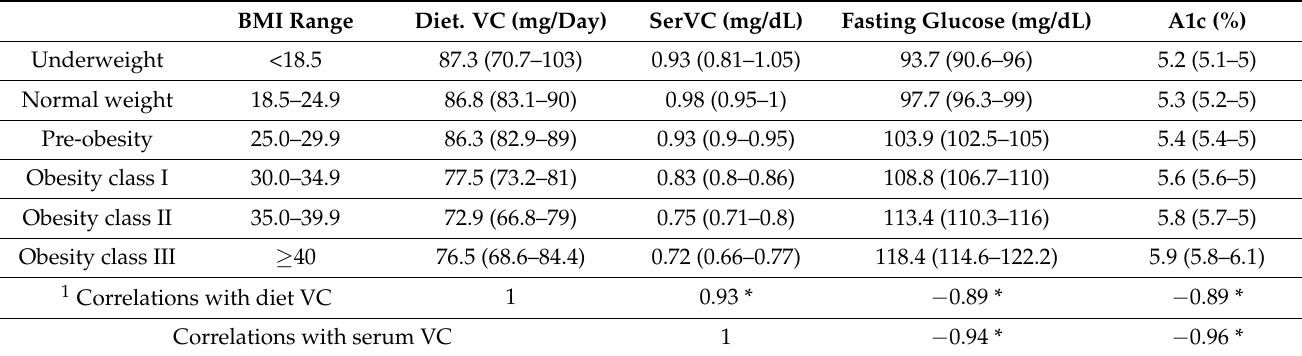
Table 3. Ranges of dietary (no supplement) VC, serum VC, glucose, and A1c of respective BMI classes and their correlations.